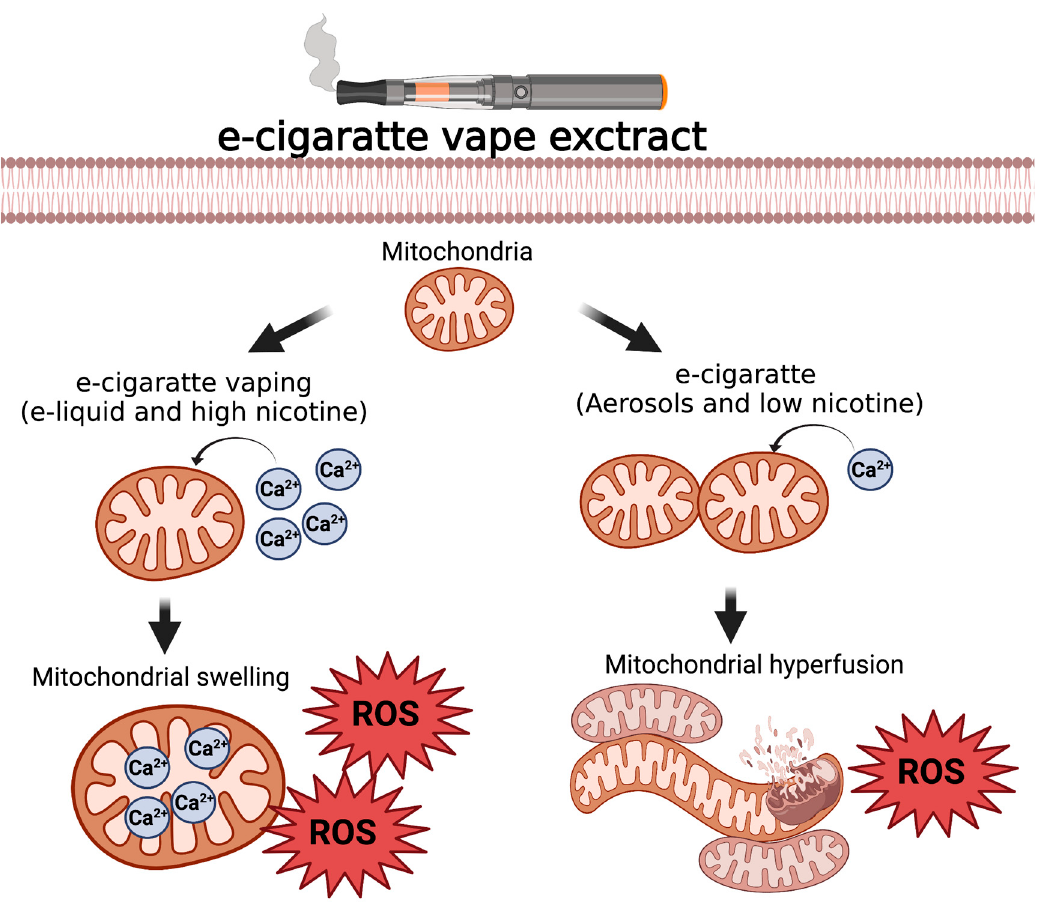
Figure 3. The effects of EC vaping on mitochondrial function. EC vaping with high concertation of nicotine causes mitochondrial swelling associated with mitochondrial calcium overload and increases ROS. EC vaping with aerosols and low nicotine concentration causes mitochondrial hyperfusion associated with stress and elevates the ROS.